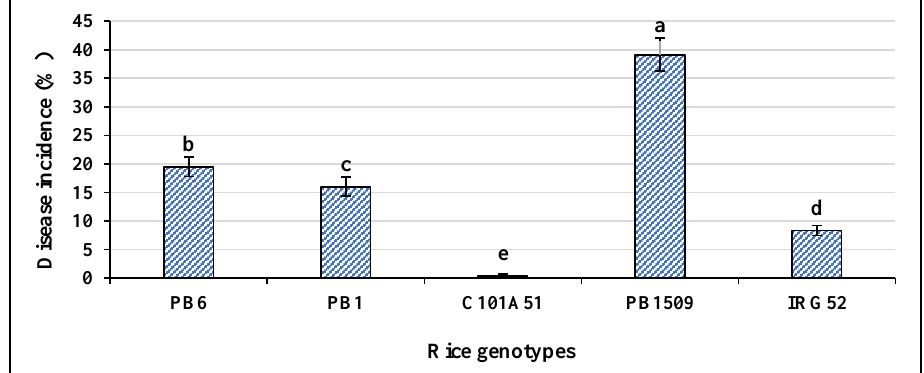
Figure 3. Disease incidence (%) in rice genotypes differing in their resistance. The disease was highest in susceptible control, followed by PB1509, PB6, PB1, and IRG52, and was the lowest in C101A51. The disease incidence is the mean of all 97 isolates in five rice genotypes. Alphabetic letters denote significant differences between the genotypes. Error bars represent standard error.